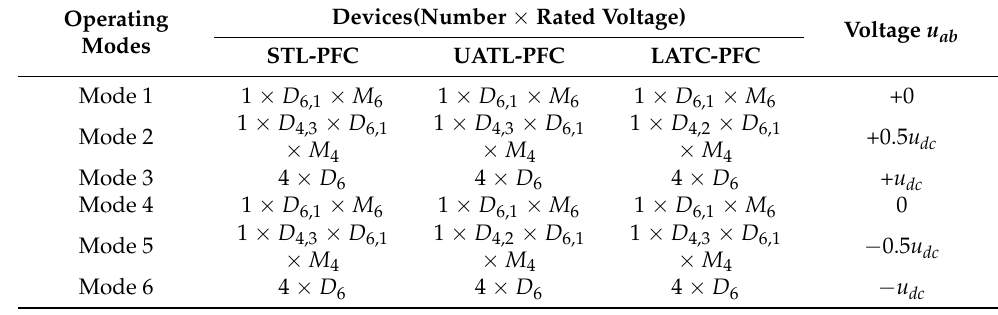
Table 3. Switching devices in conduction state under different operation modes.